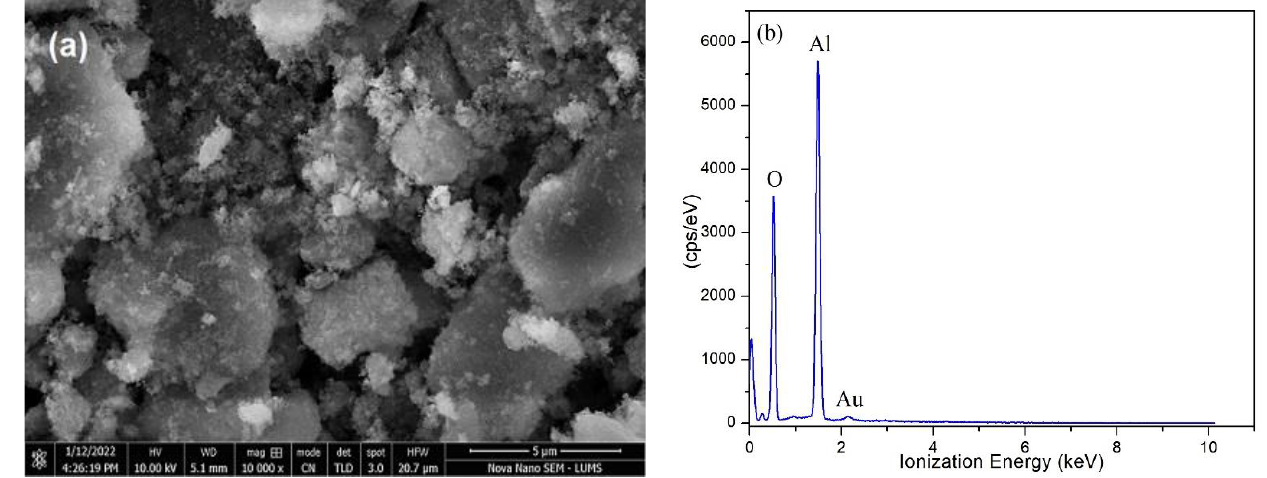
Figure 5. ( a ) SEM spectrum of alumina NPs ( b ) EDX spectrum of alumina NPs.